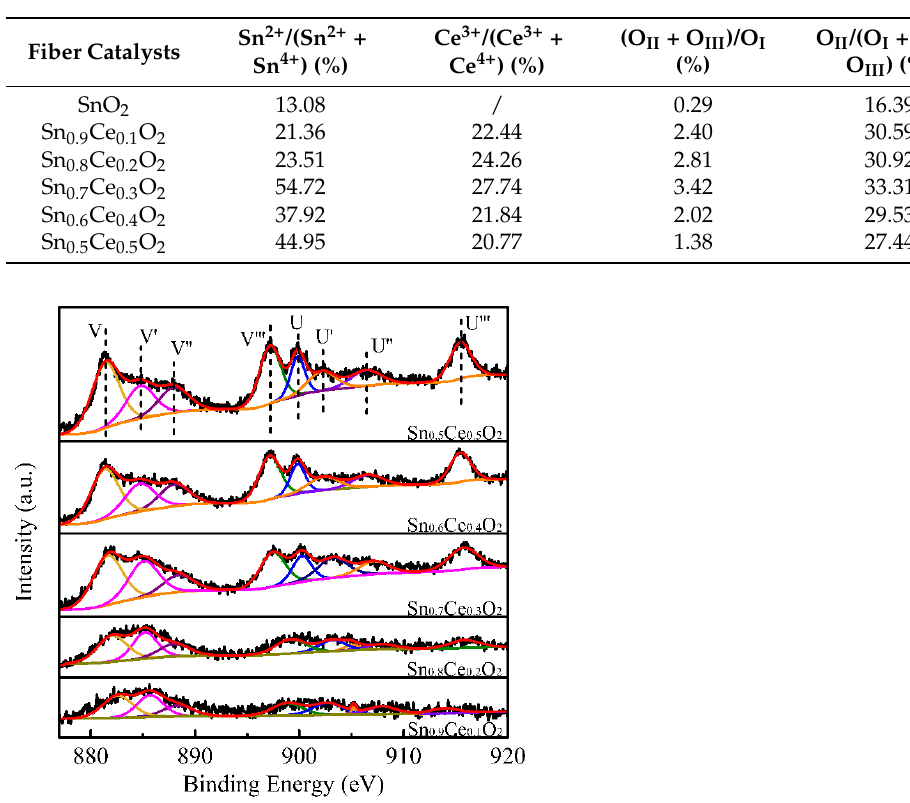
Figure 10. XPS spectra in the Ce 3d region of the Sn x Ce 1-x O 2 fiber catalysts.